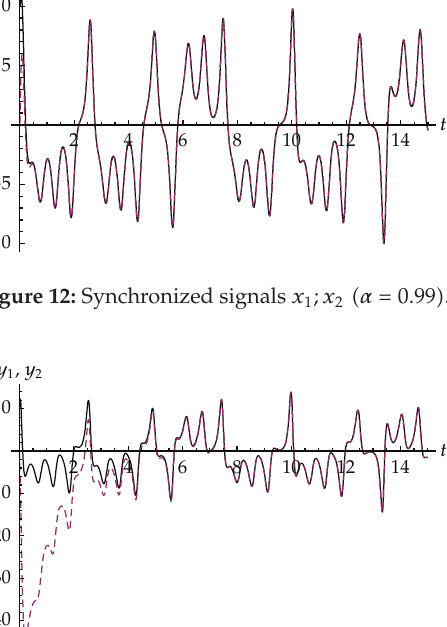
Figure 13 (cid:3) signals y 1 , y 2 (cid:4) , and Figure 14 (cid:3) signals z 1 , z 2 (cid:4) . Note that the master systems are shown by solid lines whereas slave systems are shown by dashed lines. The errors e 1 (cid:3) t (cid:4) (cid:3) solid line (cid:4) , e 2 (cid:3) t (cid:4) (cid:3) dashed line (cid:4) and e 3 (cid:3) t (cid:4) (cid:3) dot-dashed line (cid:4) in the synchronization are shown